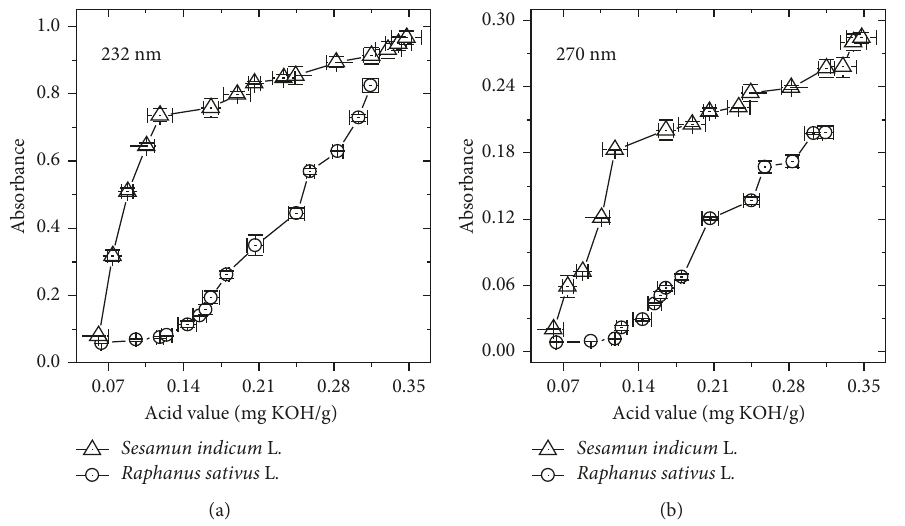
Figure 3: Correlation between the acid values and the absorbance values at (a) 232nm and (b) 270nm for the biodiesels from S. indicum L. and R. sativus L. Error bars represent standard